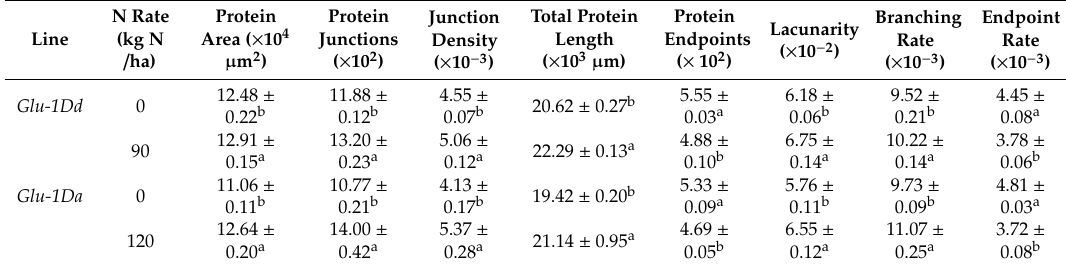
Table 1. Parameters determined by AngioTool to reflect the protein networks in the gluten containing Glu-1Dd and Glu-1Da dough.